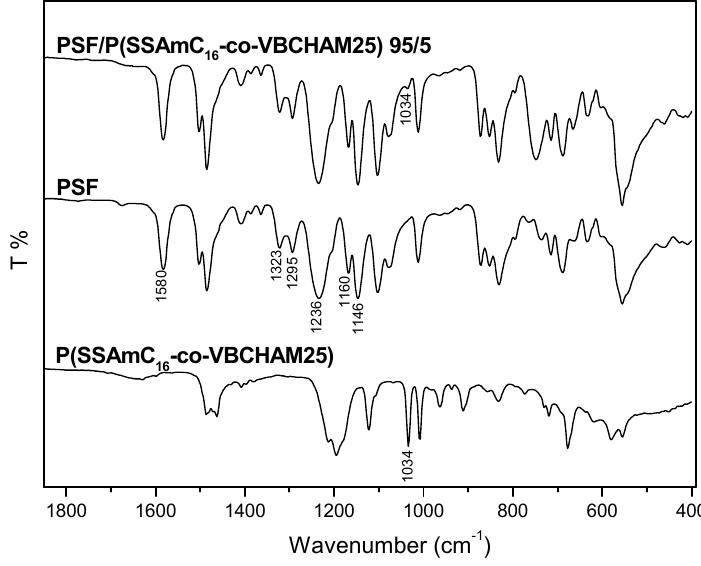
Figure 4. ATR-FTIR spectra of neat PSF, the copolymer P(SSAmC 16 -co-VBCHAM25)-D3a, as well as the membrane PSF/P(SSAmC 16 -co-VBCHAM25) at composition 95/5.